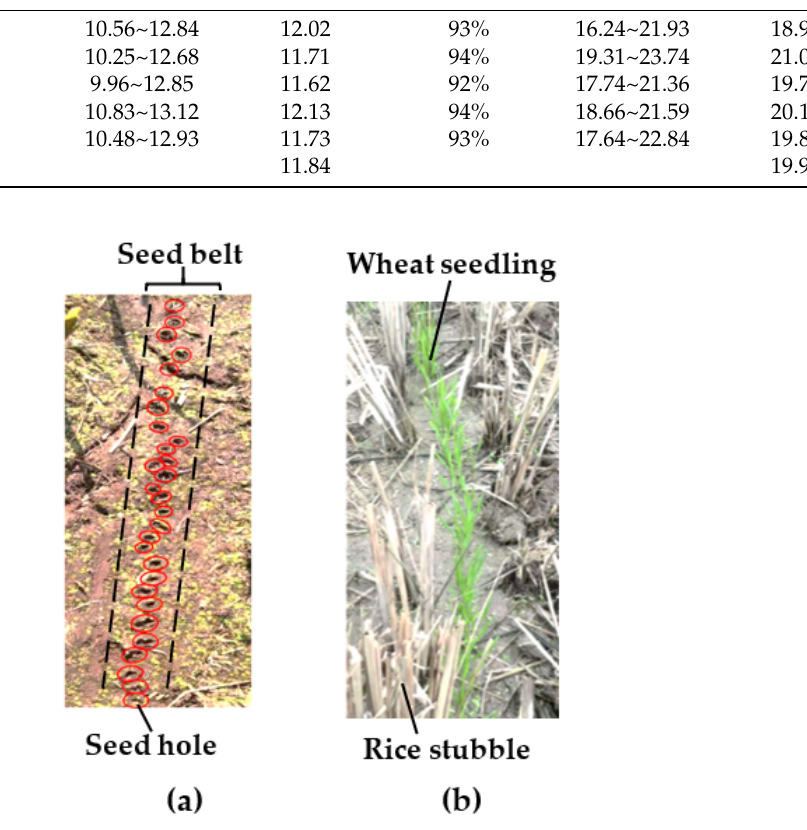
Figure 7. ( a ) Pneumatic wheat-shooting effect in field. ( b ) Seeding emergence.